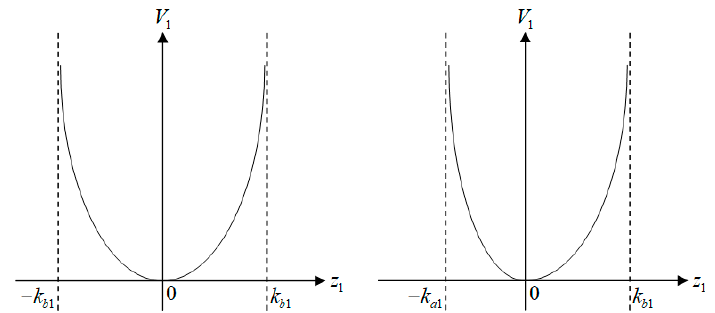
Figure 2. Symmetric ( left ) and asymmetric ( right ) barrier Lyapunov function.